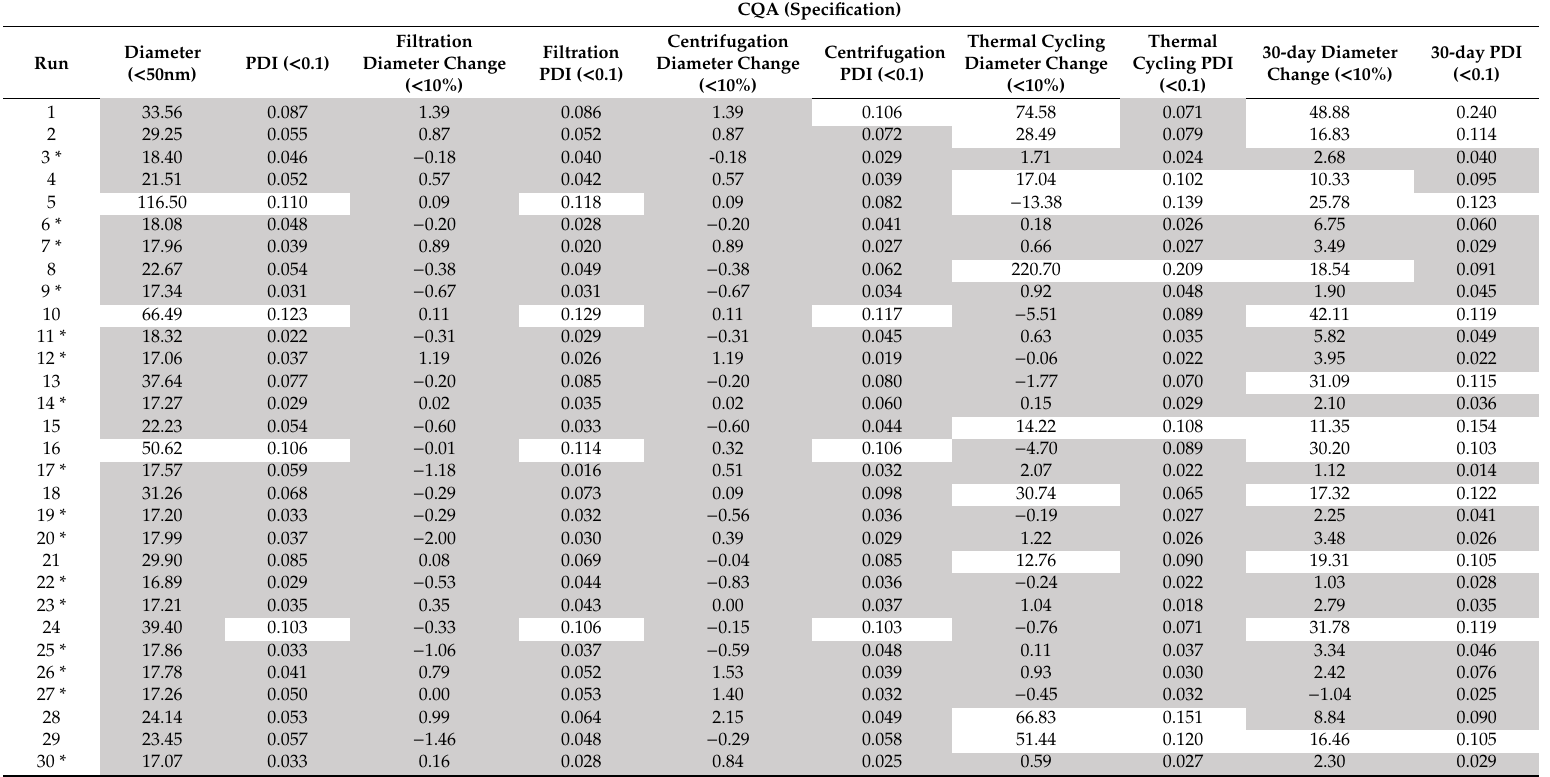
Table 5. Summary of CQA specification